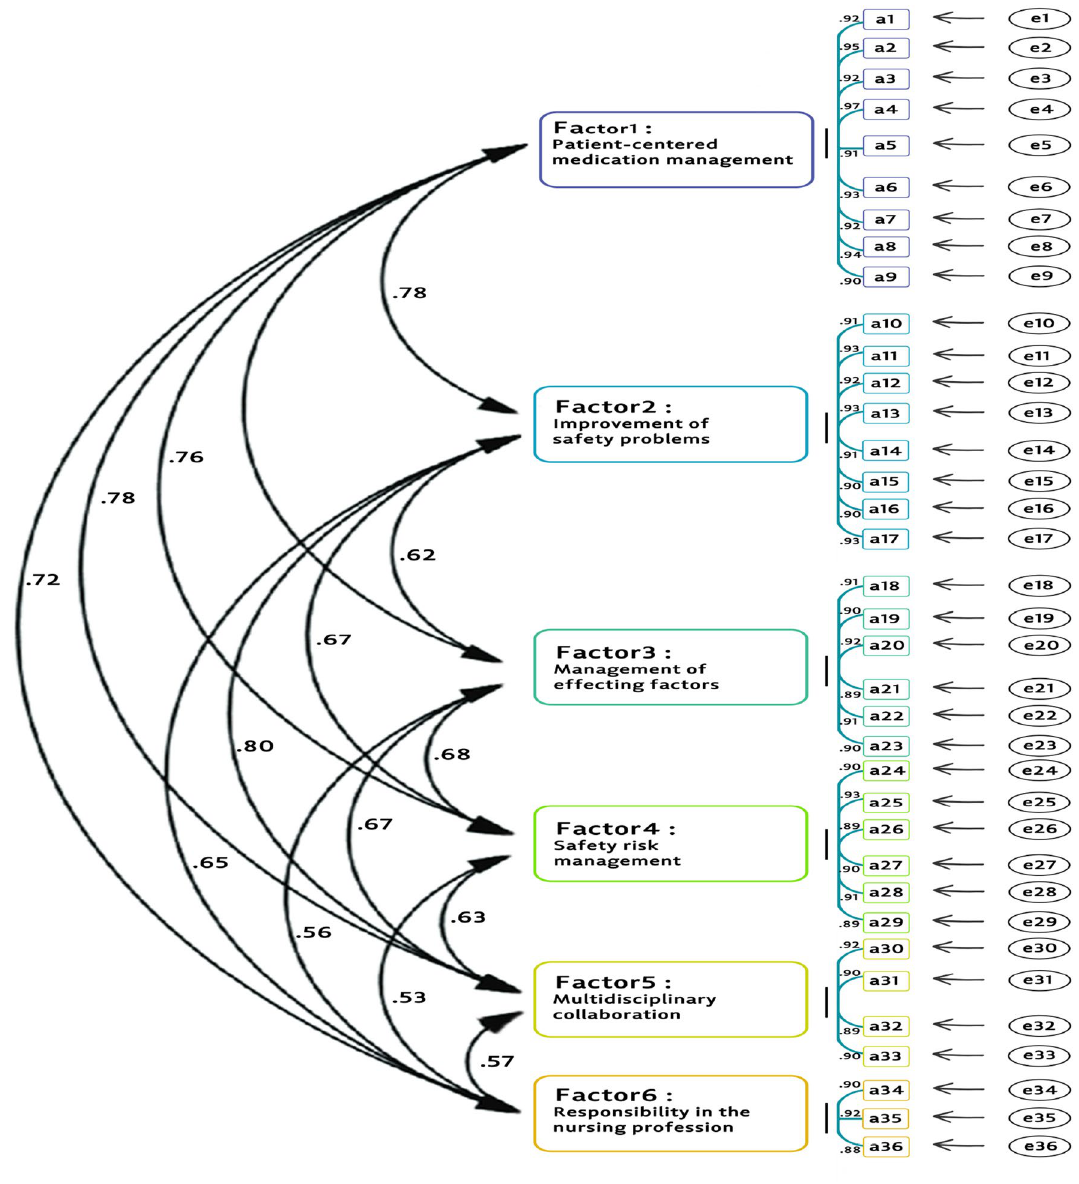
Figure 2. Confirmatory factor analysis model of the medication safety competence scale (N = 1080).